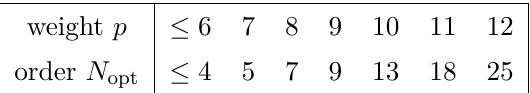
Table 6 . Optimal expansion order N opt , corresponding to the minimal value of N in eq. (3.18), such that the series expansions ˇ f of all DS functions at a given weight p become linearly